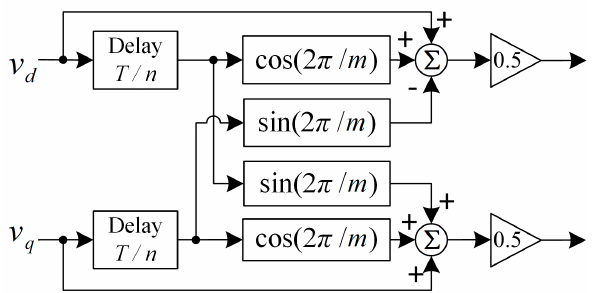
Figure 5. Time ‐ domain implementation of a modified delay signal cancellation (MDSC) operator.